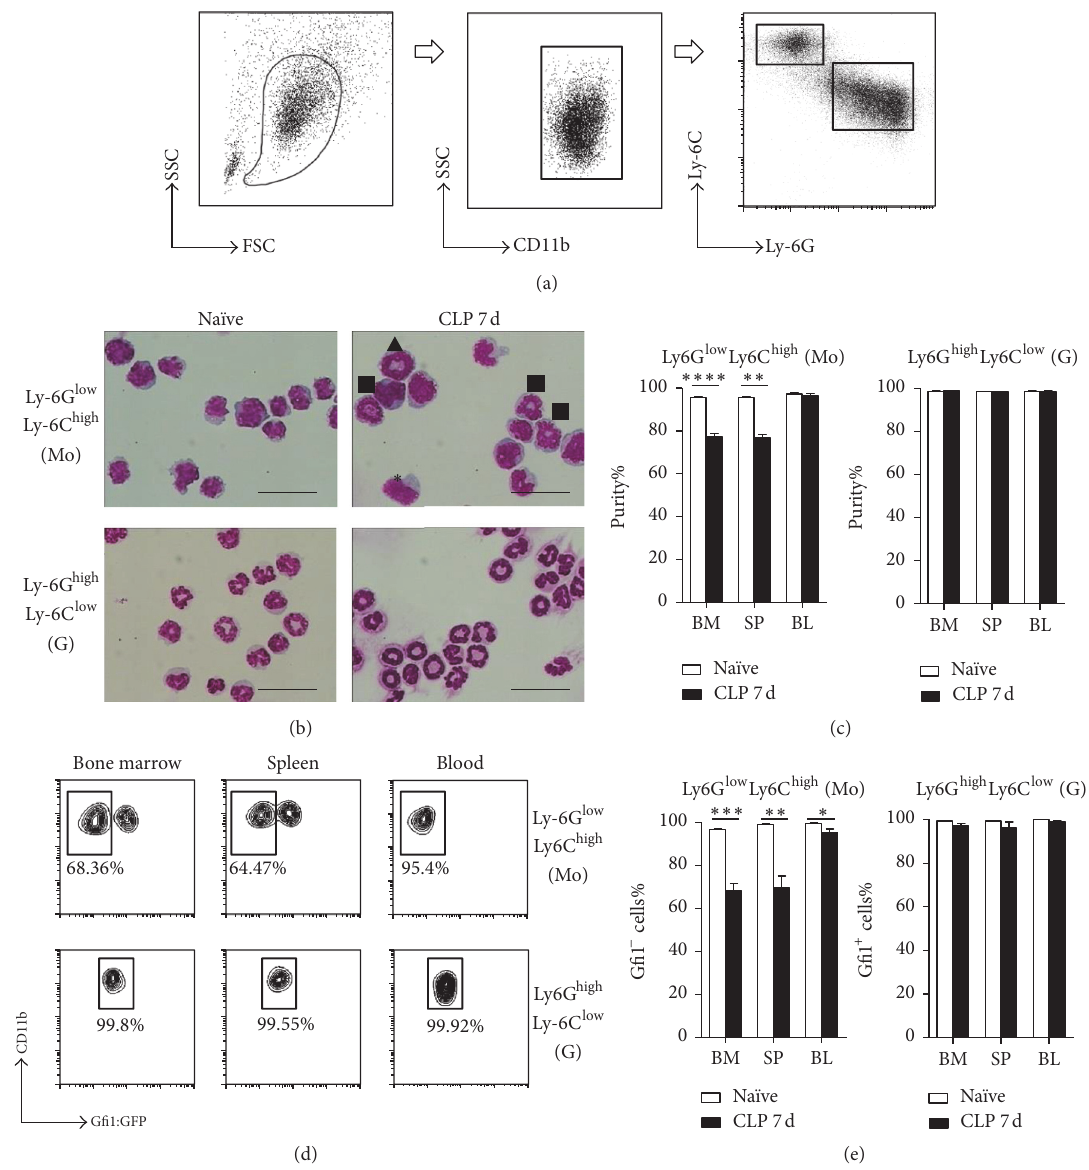
Figure 1: Purity of granulocytic and monocytic subpopulations identified by Ly6G and Ly6C. (a) Gating of monocytic and granulocytic MDSCs by Ly6C and Ly6G expression level. Cells were obtained from bone marrow, spleen, and blood from na¨ıve and 7-day CLP Gfi1:GFP knock-in mice. MDSCs were gated out from CD11b + cells and sorted as Ly 6 G high Ly 6 C low granulocytes and Ly 6 G low Ly 6 C high monocytes. (b) Representative photomicrographs (images of bone marrow are shown) of Wright–Giemsa stained MDSC subsets; 200 cells were counted in each cell preparation. Bar = 10 𝜇 m, ∗ monocyte, ◼ segmented granulocyte, 󳵳 ring granulocyte. (c) Analysis of MDSC subset purity by cell morphology. (d) Gfi1:GFP fluorescence of each MDSC subset was read. Representative graphs of flow cytometry analysis are shown. (e) Purity analysis of MDSC subsets by FACS. Data are mean ± SEM of 5–8 mice per group, ∗ 𝑃 < 0.05 , ∗∗ 𝑃 < 0.01 , ∗∗∗ 𝑃 < 0.001 , ∗∗∗∗ 𝑃 < 0.0001 .